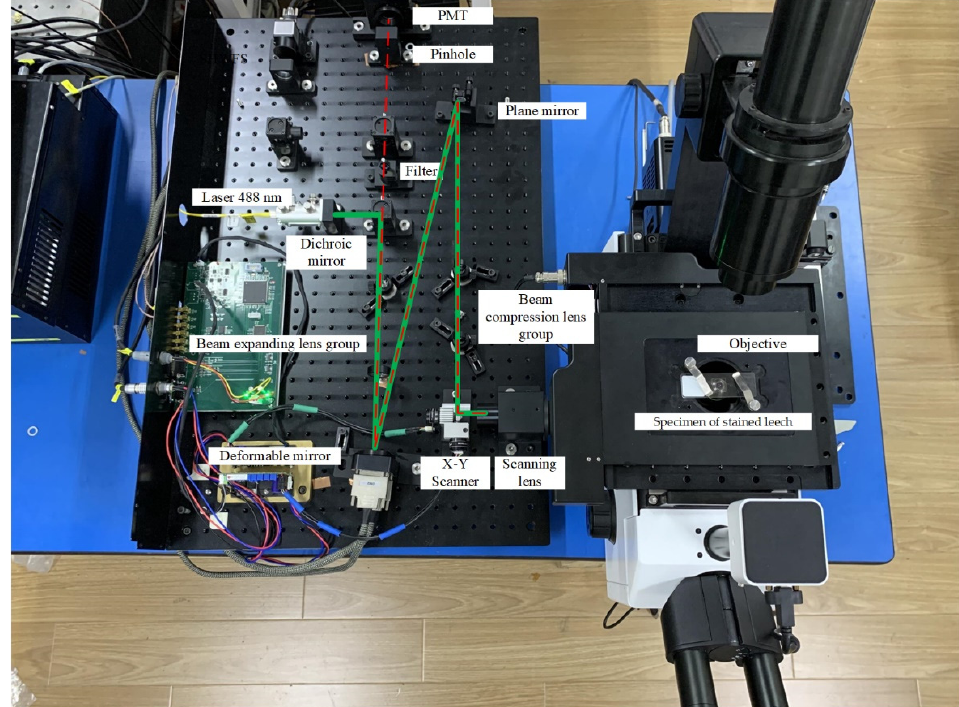
Figure 3. Photograph of the AO imaging system for LSCM.